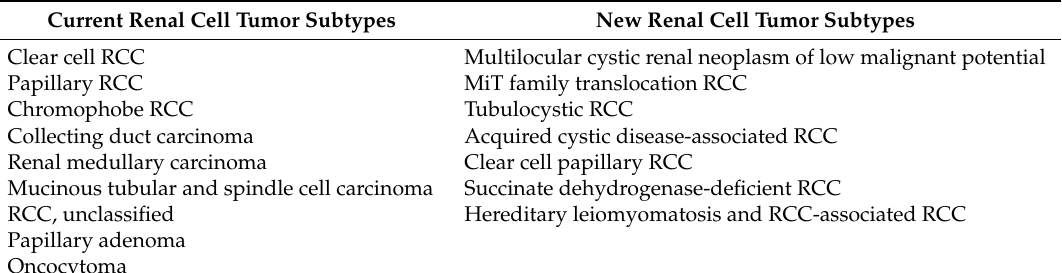
Table 1. Classification of renal cell tumors according to the 2016 WHO classification [1].